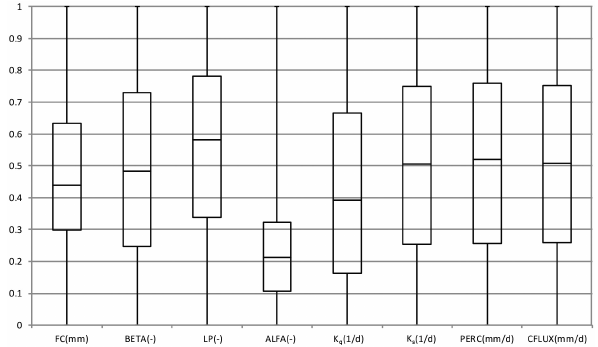
Fig. 4. Box and Whisker plots of parameters standardized by the prior range used for Monte Carlo Simulations (Gilgel Abay catch- ment). The boxes depict the median and upper and lower quartiles. The whiskers show the most extreme